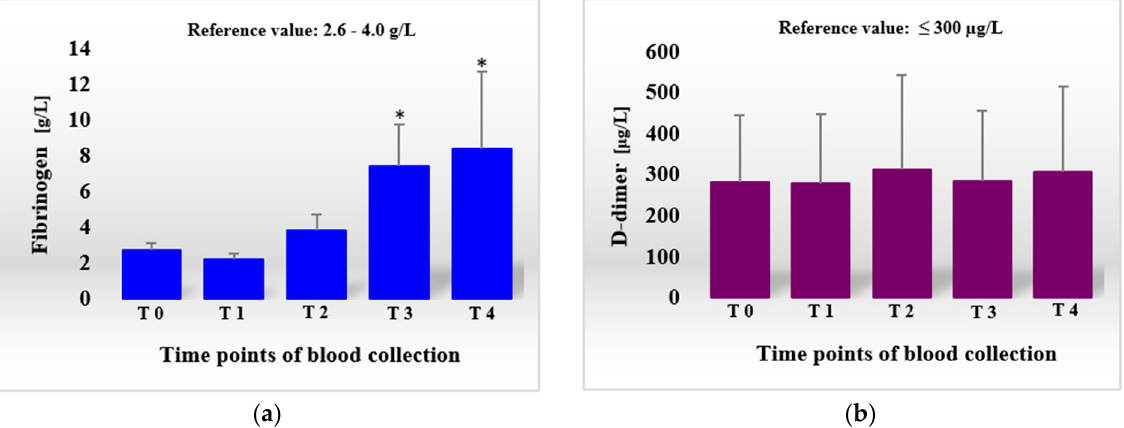
Figure 3. Concentrations of fibrinogen ( a ) and D-dimer ( b ) in the sheep before and after scaffold implantation procedure (SIP). Data are expressed as means and ± standard deviations. T0, 1 h before SIP; T1, 1 h after SIP; T2, 24 h after SIP; T3, 3 days after SIP; T4, 7 days after SIP.; * difference statistically significant at p ˂ 0.01, as compared with T0.